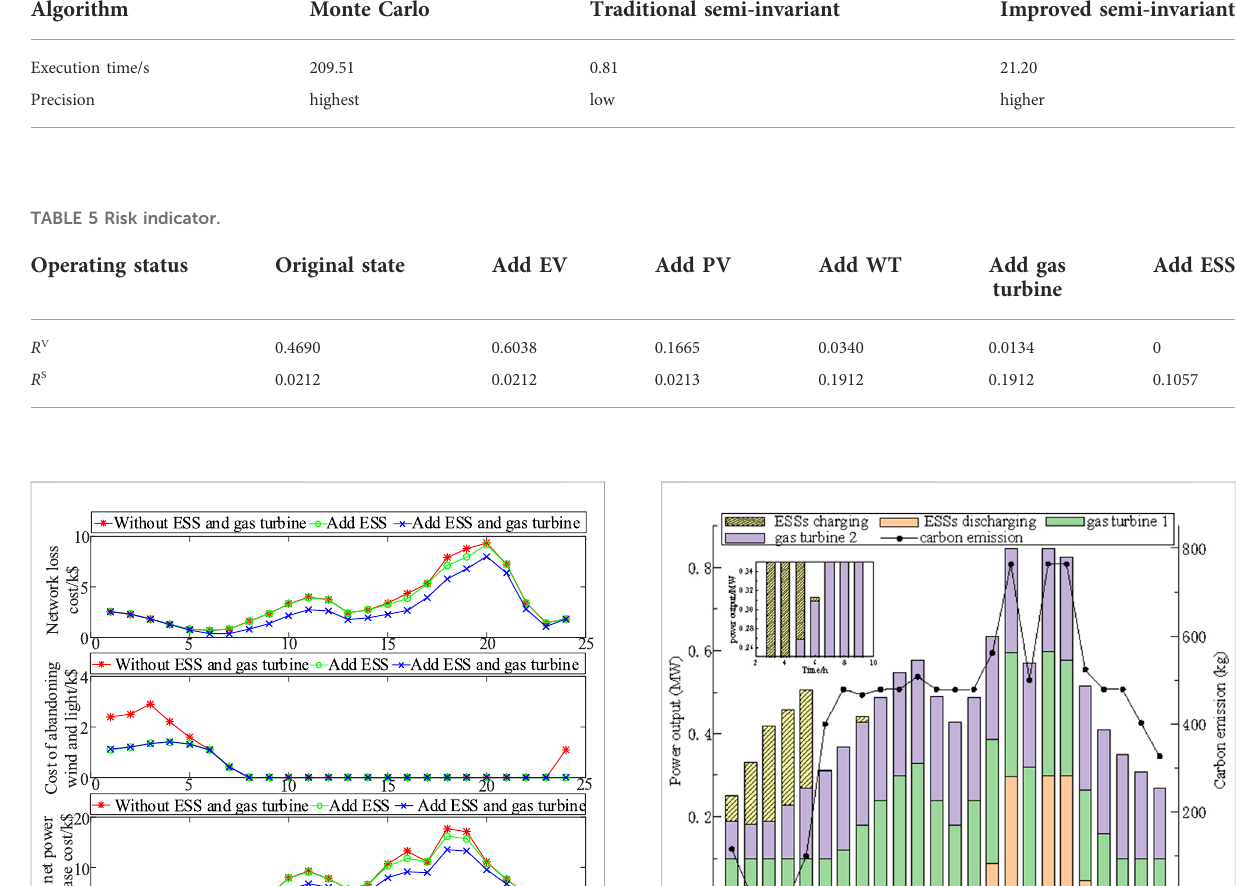
TABLE 4 Ef fi ciency and accuracy comparison.